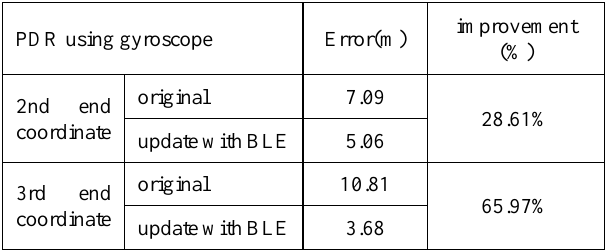
Table 6. The error of PDR using gyroscope of participant